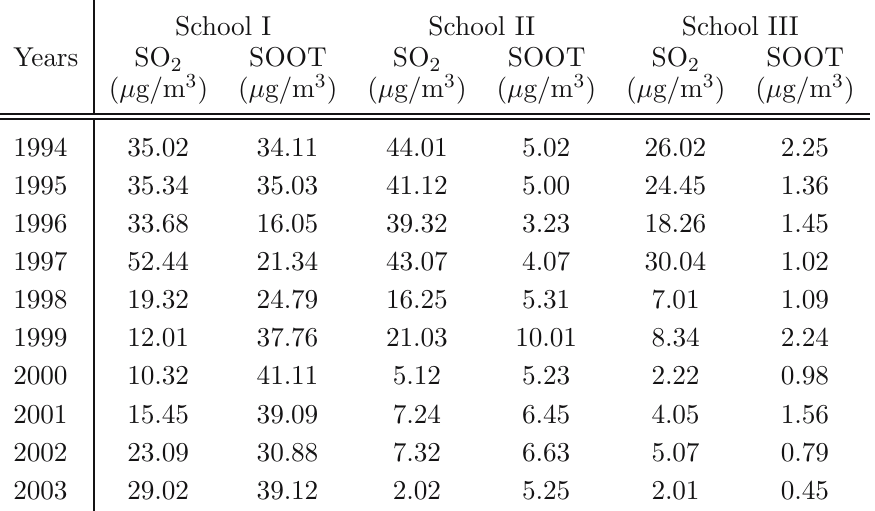
Table 2 Annual average concentrations of sulfur dioxide and soot in the period between 1994 and 2003.